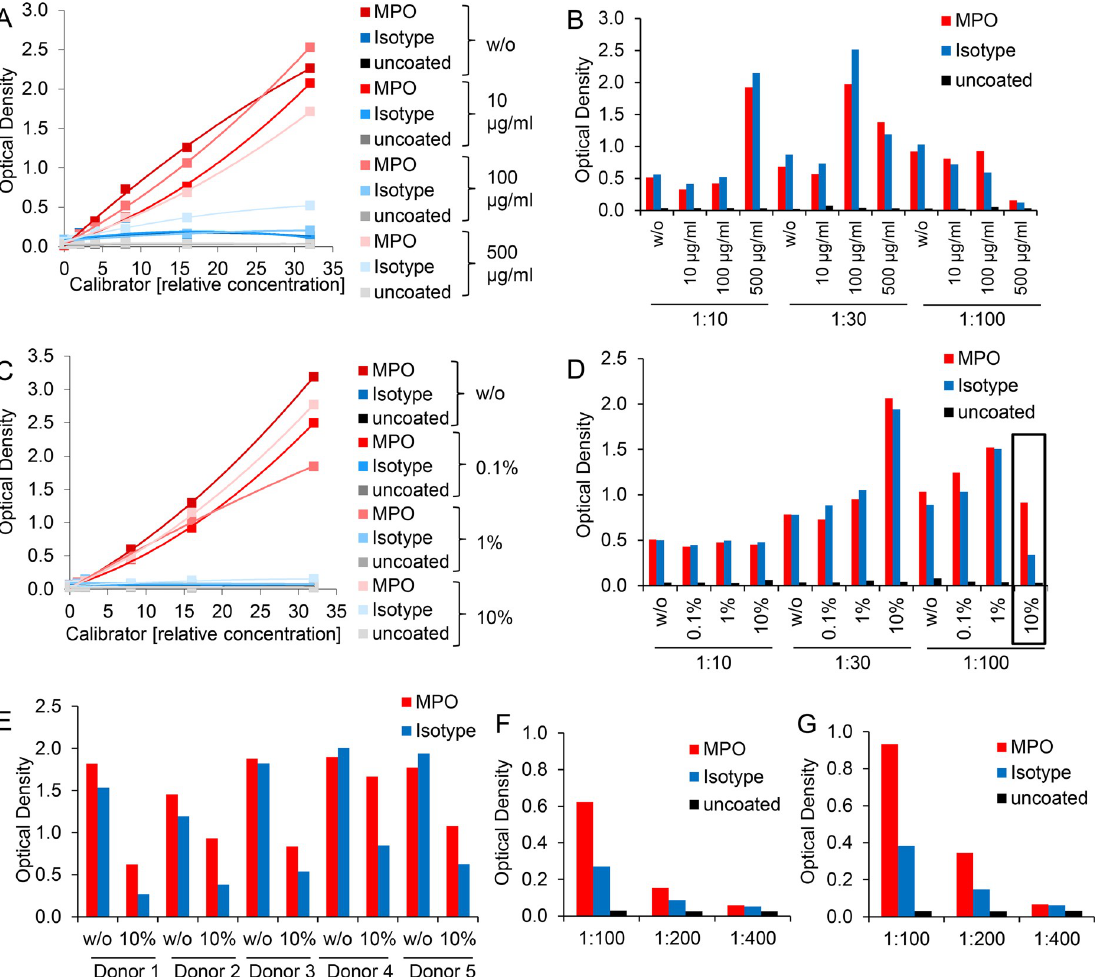
Fig 8. Approaches to block multivalent interfering substances or HAMAs may improve the ELISA selectivity for MPO-DNA complexes in human plasma. A) and C) Serially diluted calibrator or B) and D) plasma samples diluted at 1:10, 1:30 and 1:100 (with sample diluent of the ABTS ELISA Buffer Kit) were supplemented A) and B) without (w/o) or with increasing doses (10 μ g/ml, 100 μ g/ml, 500 μ g/ml) of protein A-purified mouse IgG from normal mouse serum or C) and D) without (w/o) or with graded doses (0.1%, 1%, 10%) of TRU Block Ready reagent. The further procedure of the MPO-DNA complex ELISA was performed according the initial protocol in microwells coated with MPO antibody, isotype control or left uncoated. Note that data points of uncoated microwells overlap in 8A and C. E) Plasma was diluted 1:100 without (w/o) or with supplementation of 10% TRU Block Ready reagent. The further procedure of the MPO-DNA complex ELISA was performed according to the initial protocol in microwells coated with MPO antibody or isotype control. F) and G) Plasma of two donors at dilutions of 1:100, 1:200 and 1:400 was supplemented with 10% TRU Block Ready reagent. The further procedure of the MPO-DNA complex ELISA was based on the initial protocol with microwells coated with MPO antibody or isotype control or left